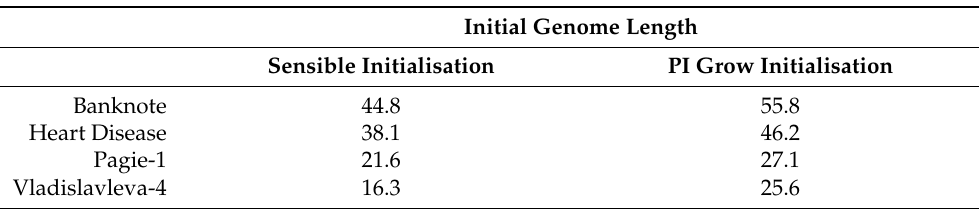
Table 4. Average of the genome length in the first generation in 30 runs using sensible initialisation or PI Grow initialisation on